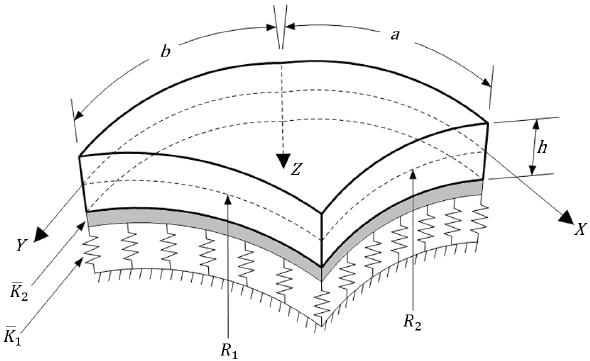
Figure 1: Coordinate system and geometry for a doubly curved panel supported by a Pasternak-type elastic